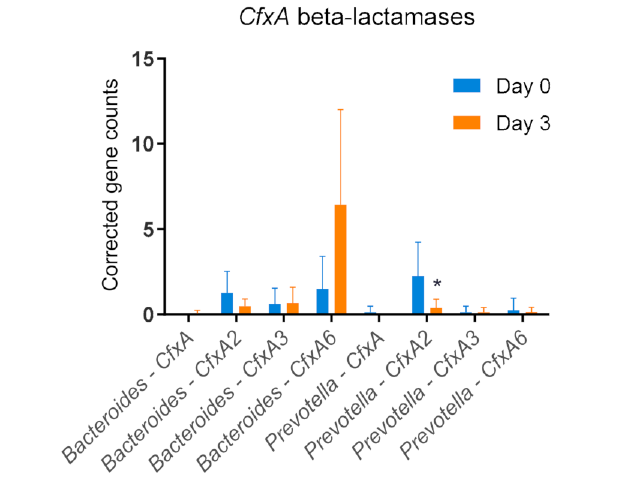
Figure 7. Bar plots (+standard deviation), showing the mean CfxA resistance gene counts on Bac- teroides and Prevotella before and after treatment, i.e., 9 h after the last dose of the daily intramuscular administration of 3 mg · kg − 1 body weight of ceftiofur for 3 consecutive days, corrected to the relative (pre-treatment to post-treatment) base counts of Bacteroides and Prevotella. D0 = day 0, D3 = day 3. Significance codes: ‘*’ p -value <